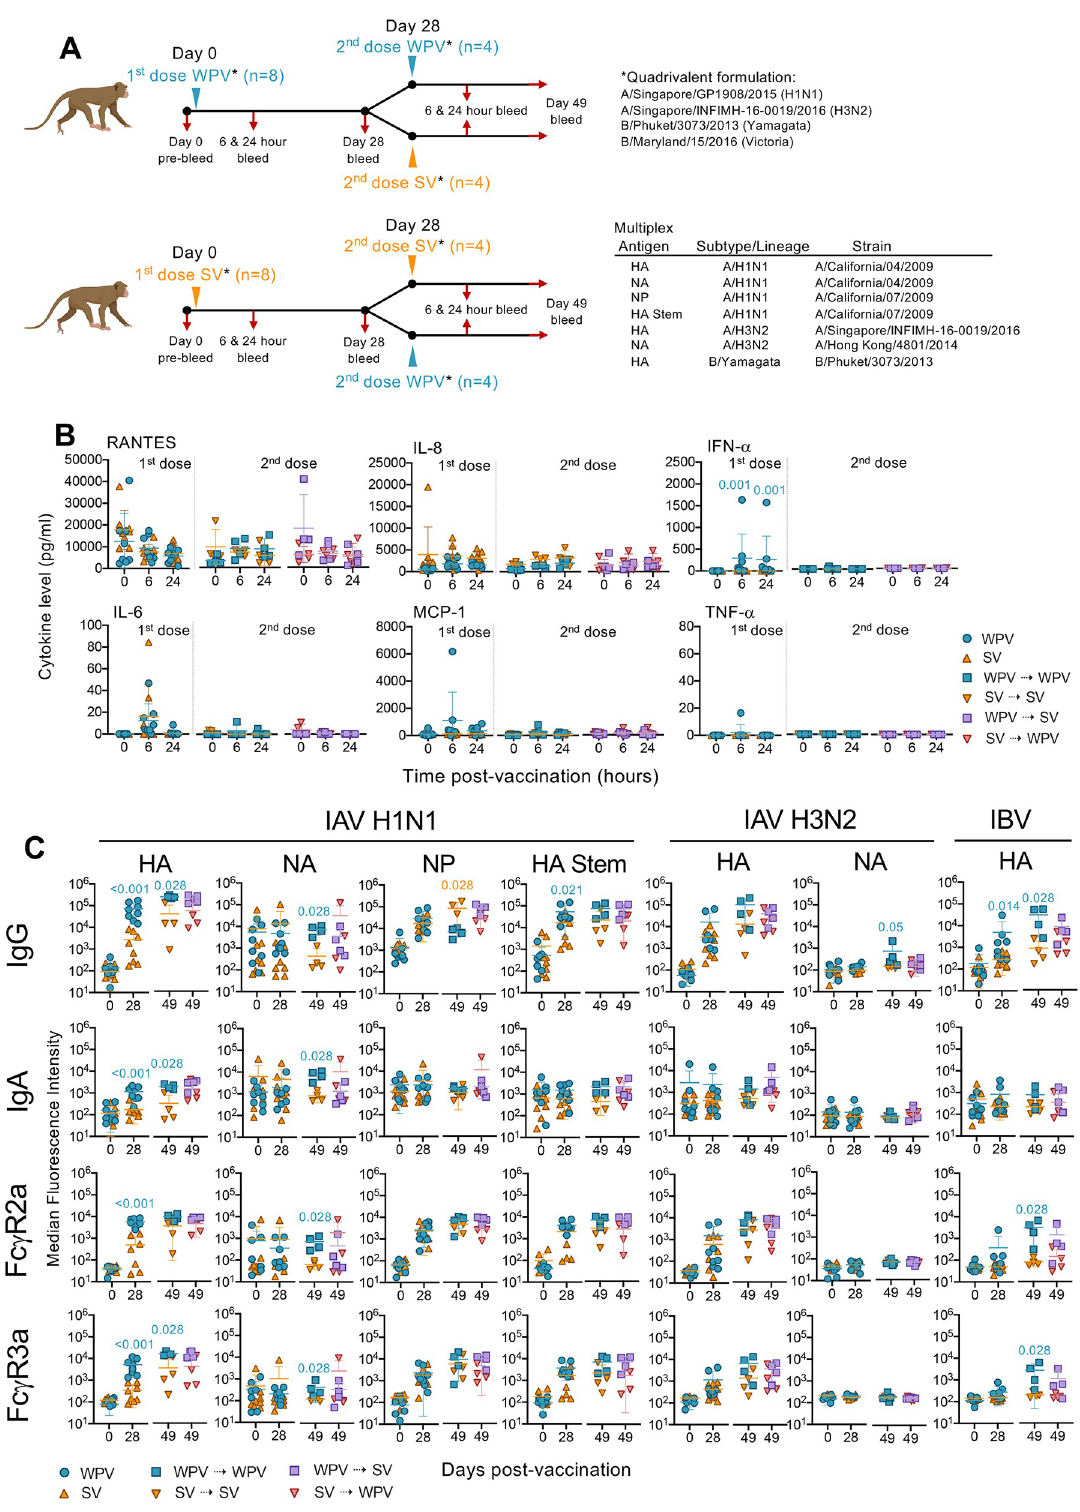
Fig 3. Quadrivalent WPV induces stronger antibody responses to vaccine matched strains than SV. (A) Macaques (n = 8 per group) were vaccinated with quadrivalent WPV or SV formulations. A second dose of either the same (n = 4) or opposite formulation to the first vaccine used (n = 4) was administered 28 days later. (B) Cytokine levels in the plasma obtained at 6 and 24 hours following each